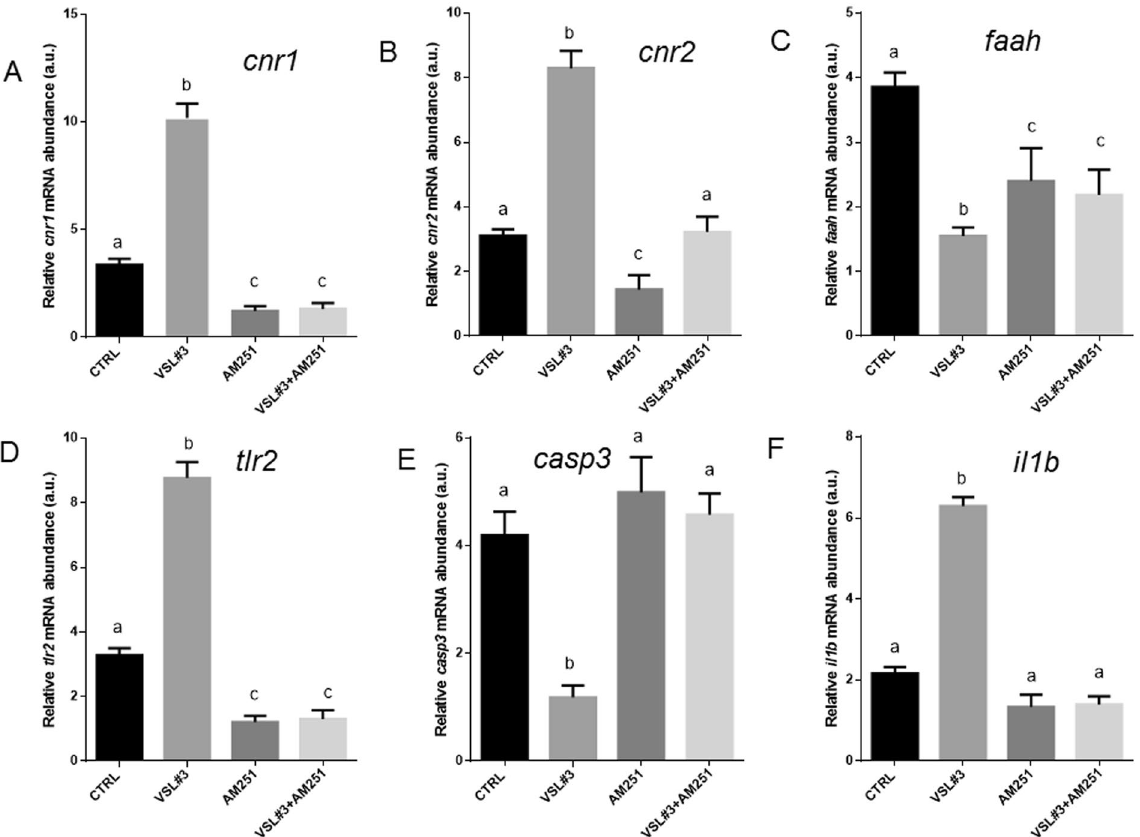
Figure 5. Intestinal mRNA levels evaluated by qPCR of ( A ) cnr1 , ( B ) cnr2 , ( C ) faah , ( D ) tlr2 , ( E ) casp3 and ( F ) il1b normalized against act1b and rplp , in different experimental groups from ex vivo experimentation. Values indicate mean ± SD. Different letters denote significant differences among